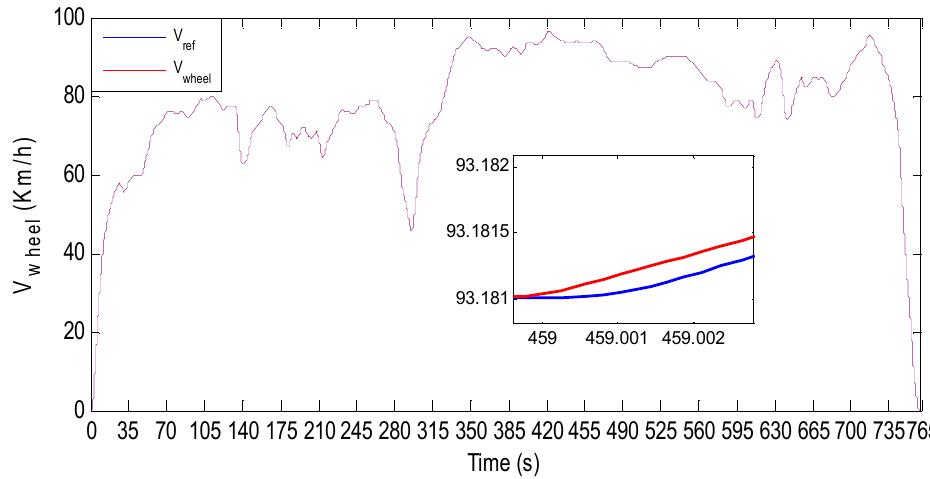
Figure 30. BEV speed response and its reference for HWEFT driving cycle.